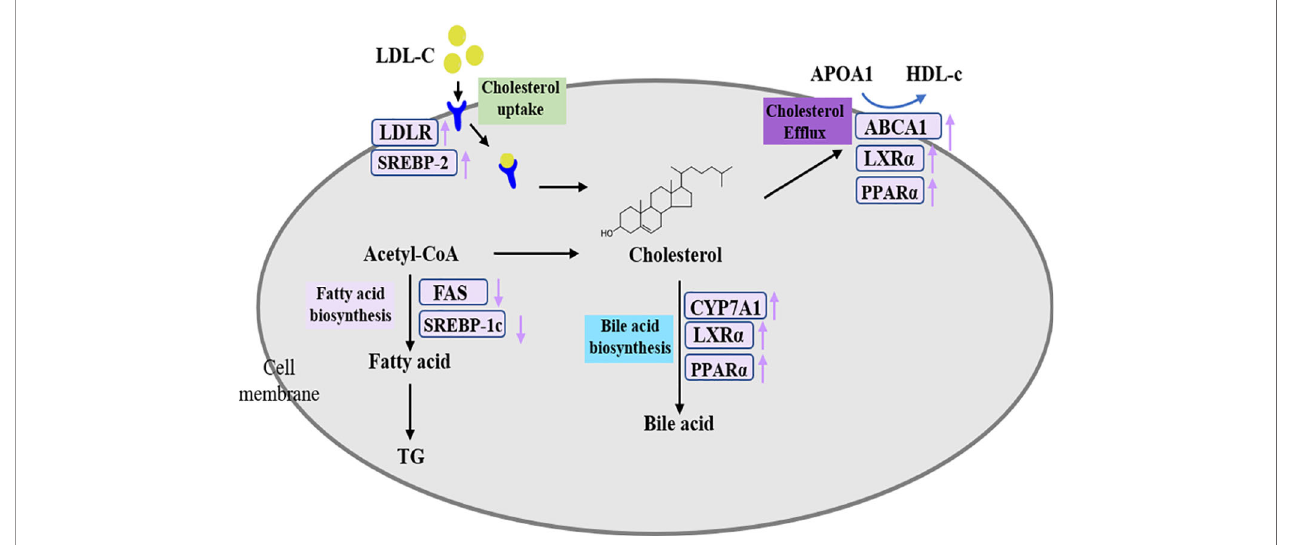
FIGURE 8 | The proposed mechanism of DHG in treatment of